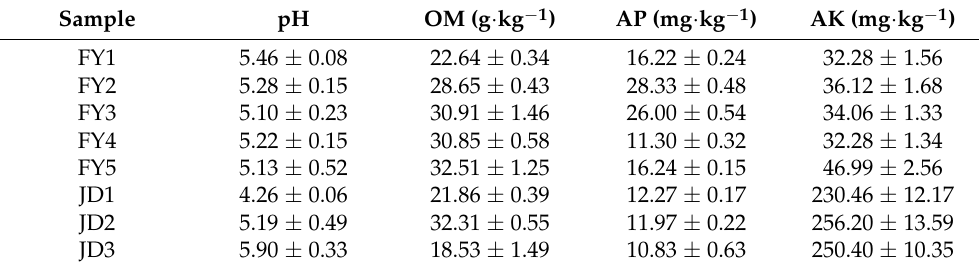
Table 2. Chemical properties of soil samples collected from Fuyang and Jiande districts. Sample